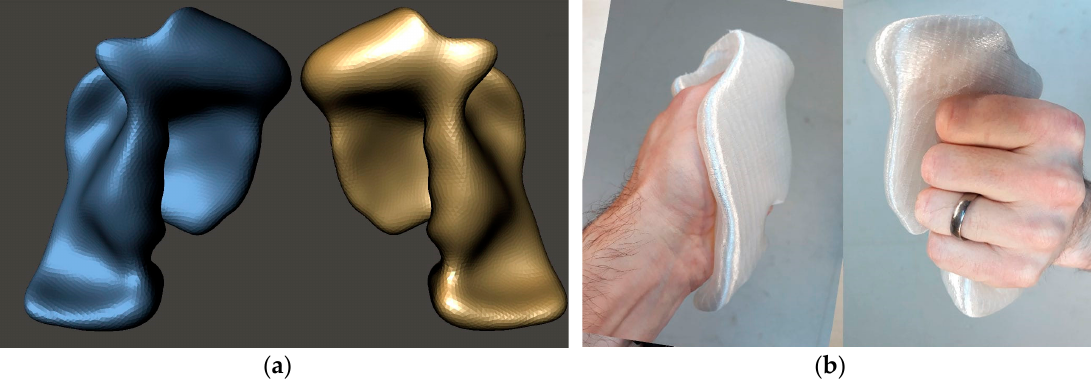
Figure 6. Latest design solution: ( a ) final CAD models of the pair of customised wheelchair racing gloves; ( b ) the 3D printed gloves being tested for fit using Premium PLA (Raise3D) material. Table 1. Comparison between original solid moulded gloves and 3D printed alternatives. Glove Model Mass (g) original